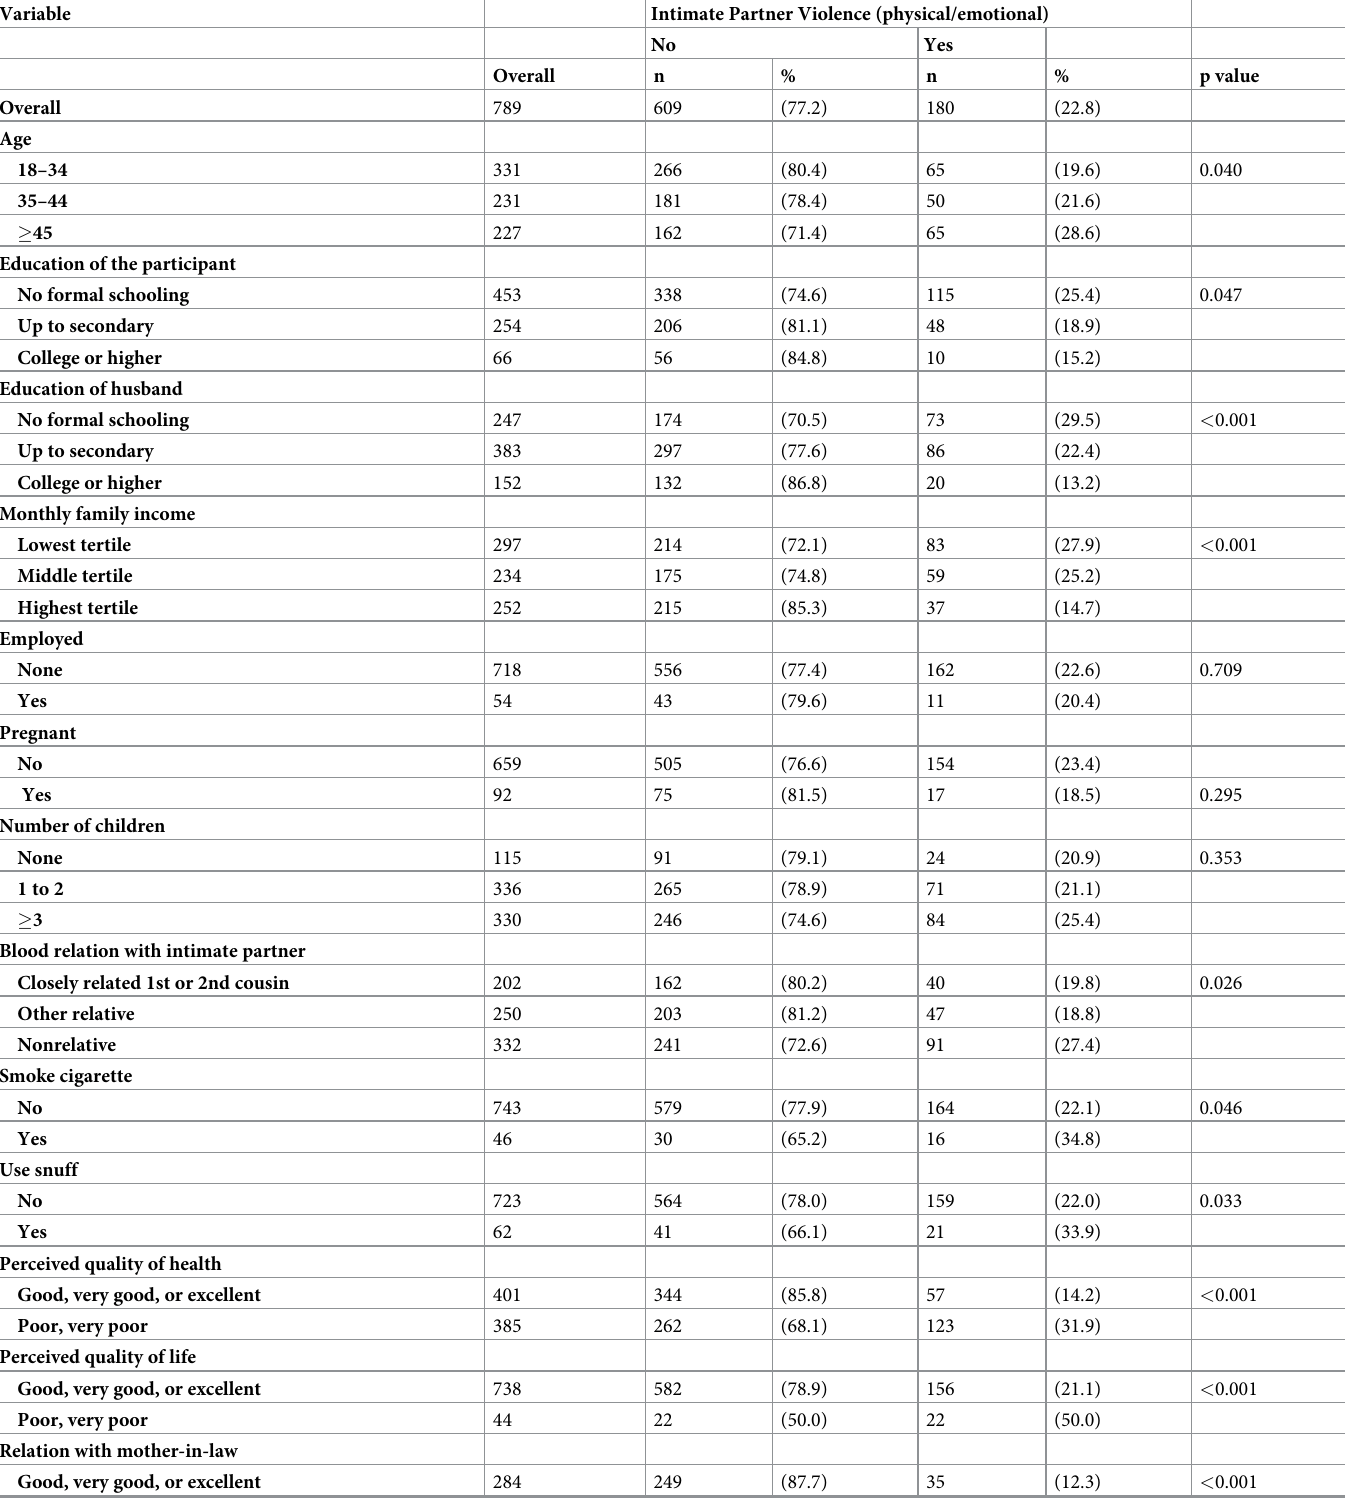
Table 1. Prevalence and predictors of intimate partner violence among married women in Himalayan Mountain Villages (n = 789), Pakistan: Bivariate analyses.